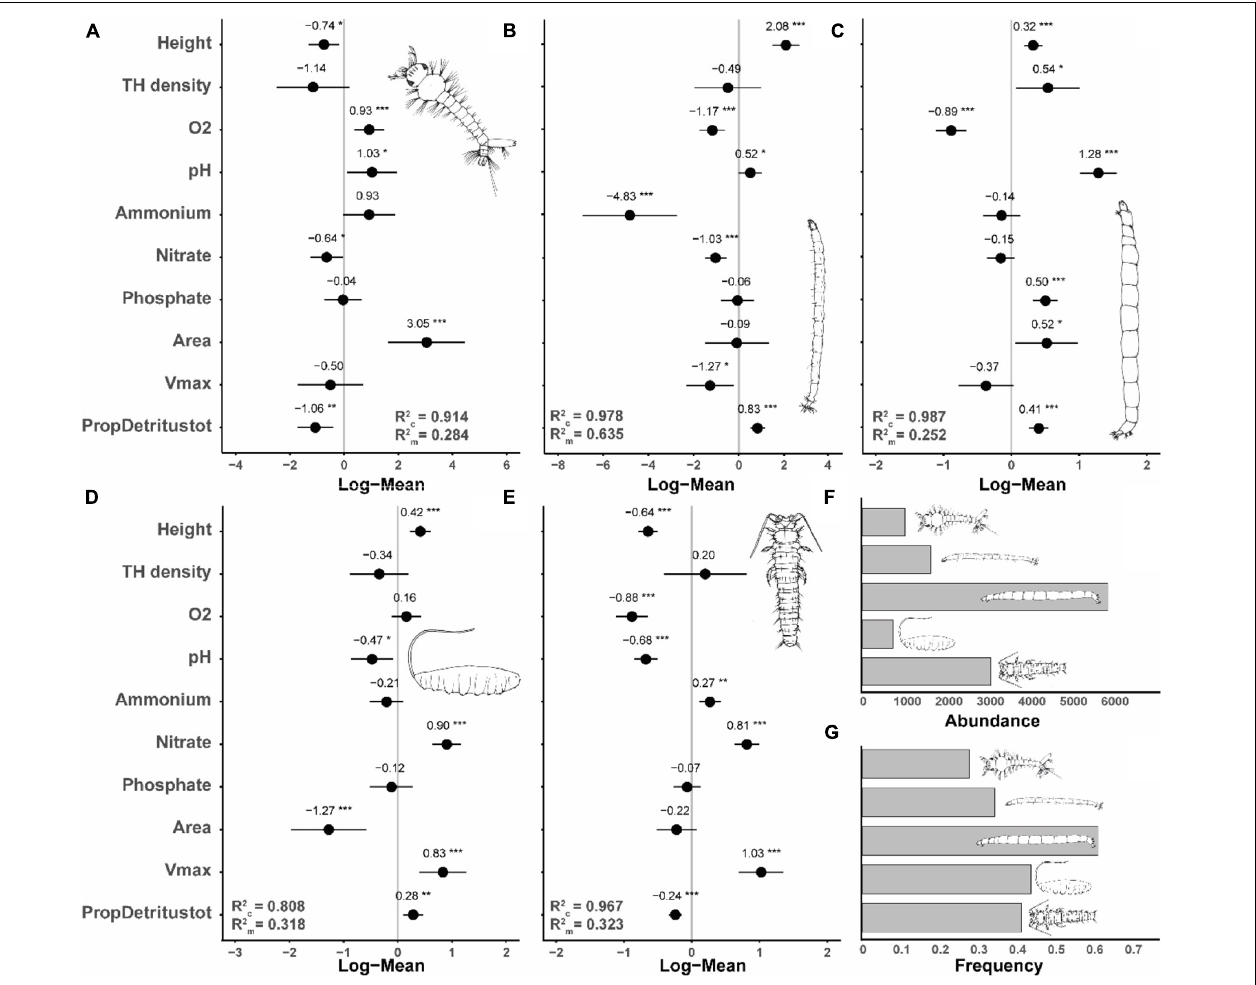
FIGURE 3 | Standardized model coefficients (including conditional and marginal R 2 -values) of generalized linear mixed effects models with a Poisson distribution, showing the importance of tree-hole height above ground, tree-hole density (canopy and ground holes combined), tree-hole opening area, tree-hole maximum water volume (Vmax), water chemistry [dissolved oxygen concentration (O 2 ), pH, and ammonium, nitrate and phosphate concentrations], and total amount of detritus relative to Vmax (PropDetritustot) in determining the abundance of the five most frequently observed insect species. (A) Diptera, Culicidae: Aedes geniculatus , occurrence in n = 88 tree holes; (B) Diptera, Ceratopogonidae: Dasyhelea sp., n = 109; (C) Diptera, Chironomidae: Metriocnemus cavicola , n = 194; (D) Diptera, Syrphidae: Myiatropa florea , n = 139; (E) Coleoptera, Scirtidae: Prionocyphon serricornis , n = 131. (F,G) show the total abundance and the frequencies of occurrence of the five species, respectively. * p < 0.05, ** p < 0.01, *** p <